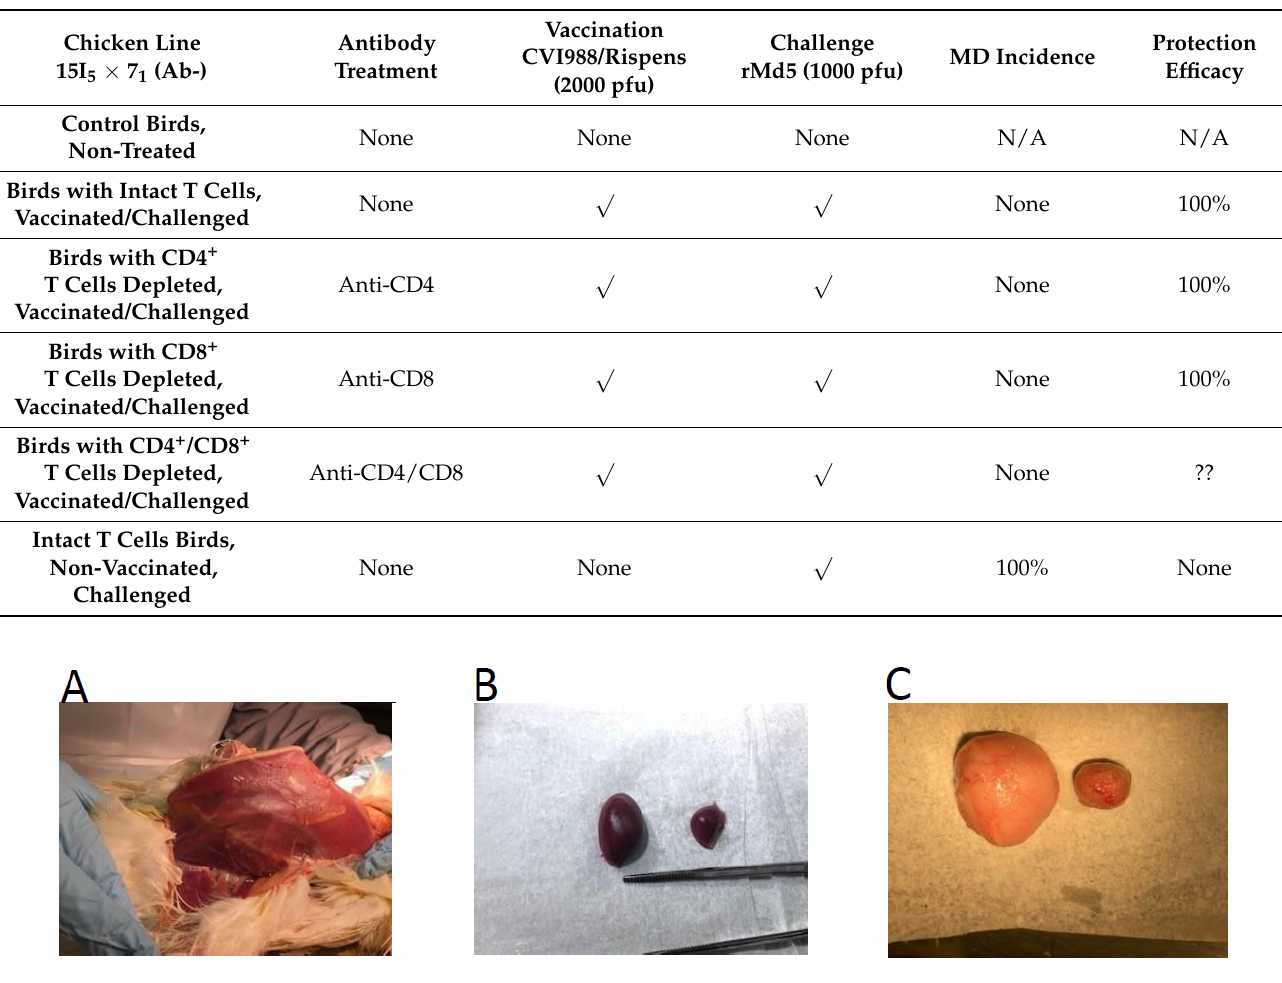
Table 4. Protection efficacy of vaccination in T Cell depleted and challenged birds.